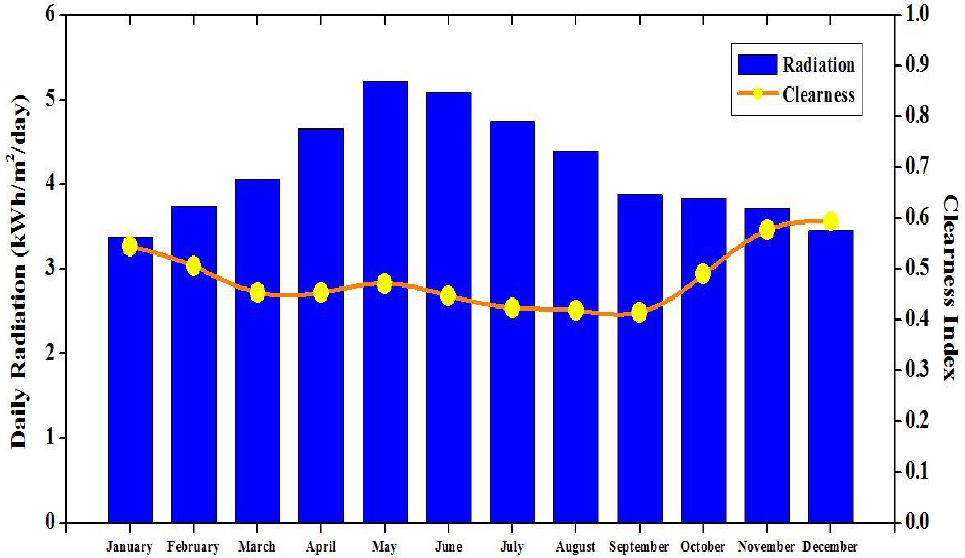
Figure 5. Monthly per day average solar irradiation in Yupia [53].